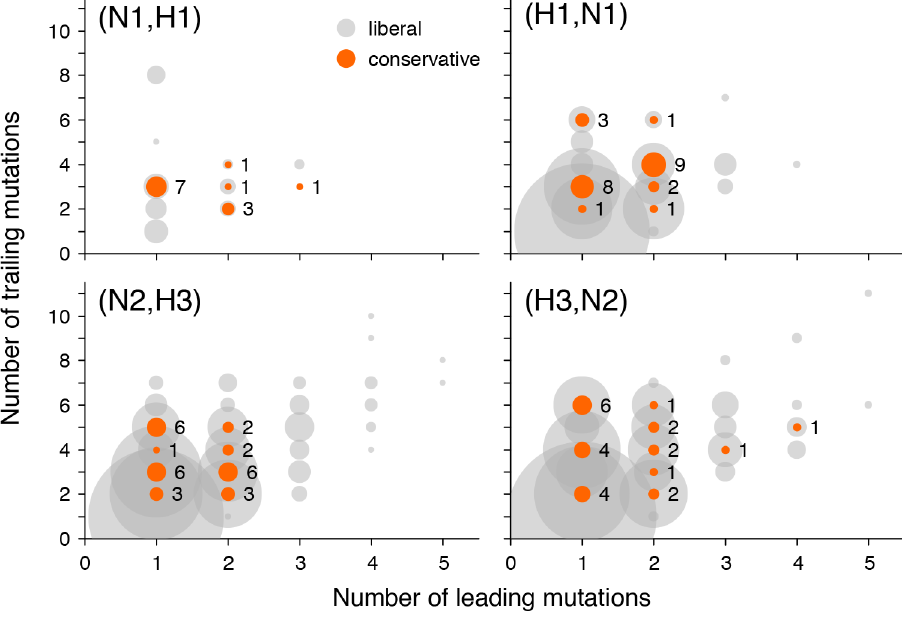
Fig 5. Numbers of leading and trailing mutations at putatively epistatic site pairs in different gene pairs. Circle area corresponds to the number of site pairs with each number of leading and trailing mutations at liberal (grey) or conservative (orange) P- value thresholds. To gauge the scale, the numbers of pairs at conservative P- value thresholds are shown next to the orange circles.